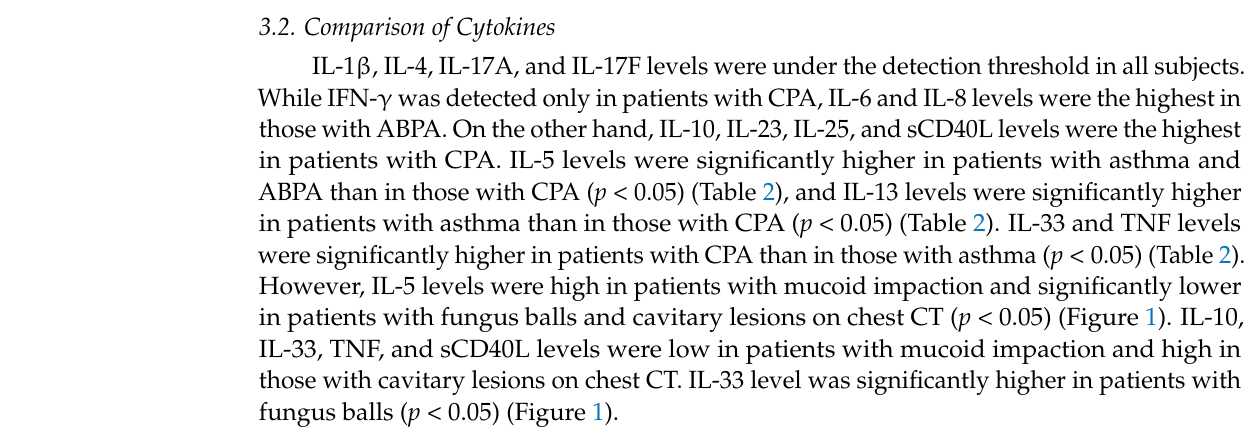
Table 2. Serum cytokine